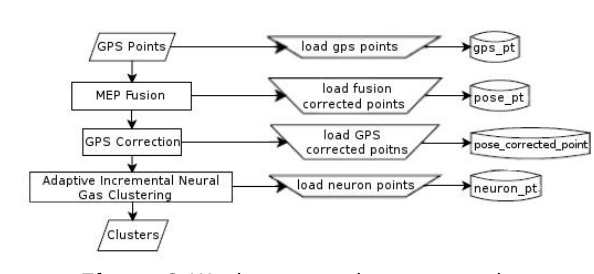
Figure 6 . Worker general process